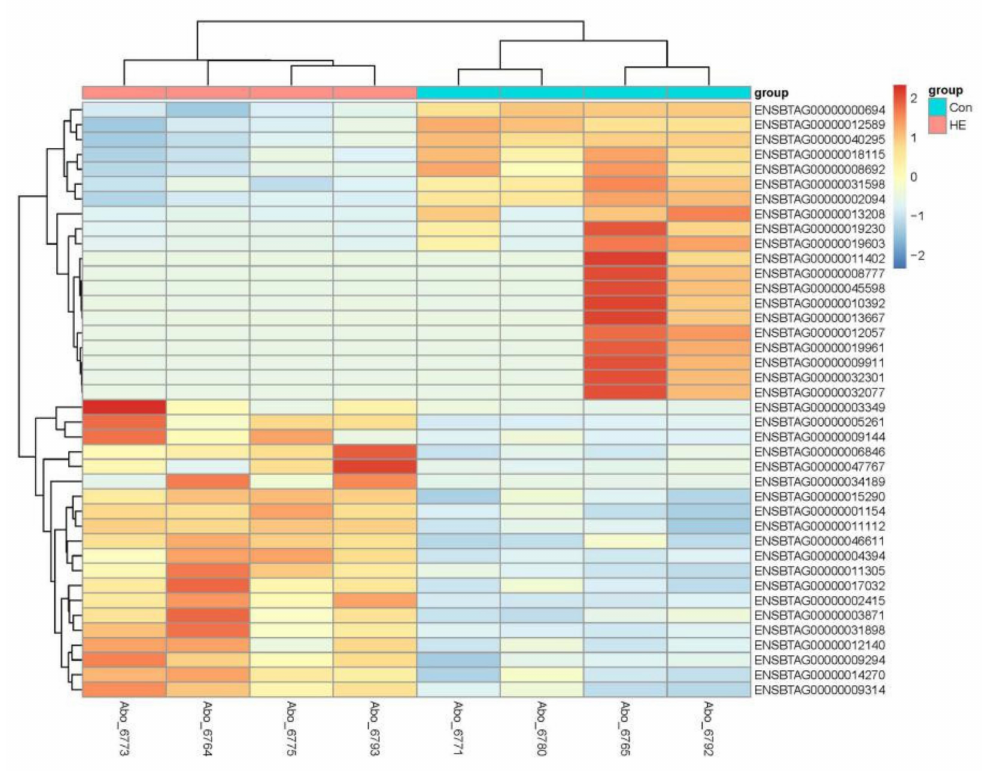
Figure 2. Heatmap showing top 40 DEGs between treatments. The log2 ratio values of DEG abundance were used for cluster analysis with the R pheatmap package. Red and blue indicate relative over- or under-expression of genes,